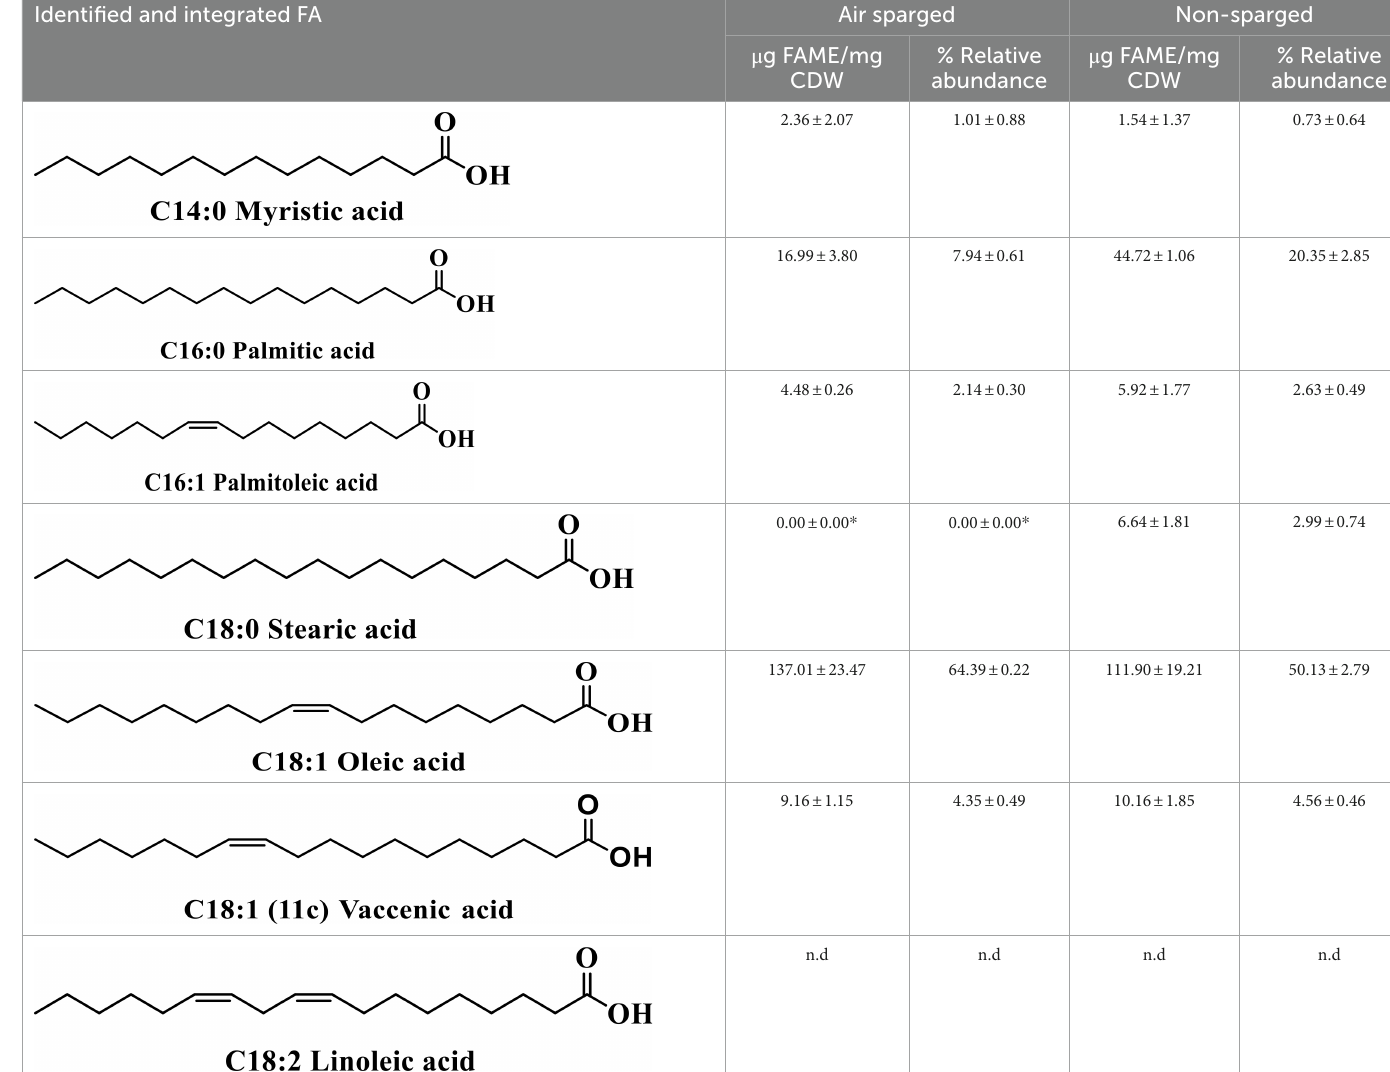
TABLE 2 Effect of different aeration conditions on the fatty acid composition of the cell membranes of Limosilactobacillus reuteri DSM 17938. Identified and integrated